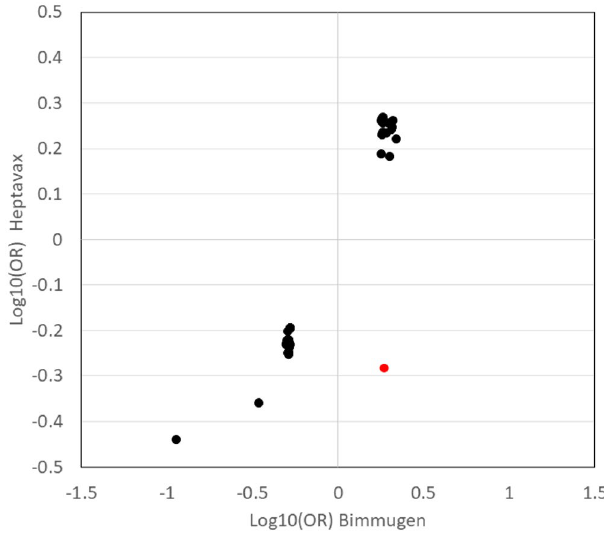
Figure 2. Comparison of odds ratios between Heptavax and Bimmugen for 72 SNPs with P < 0.0001 in the Bimmugen GWAS (Group_0 vs. Group_2). Red dot indicates an SNP with opposite OR in the GWAS between Heptavax-II and Bimmugen vaccines (rs12595417, shown in Supplementary Table 3).